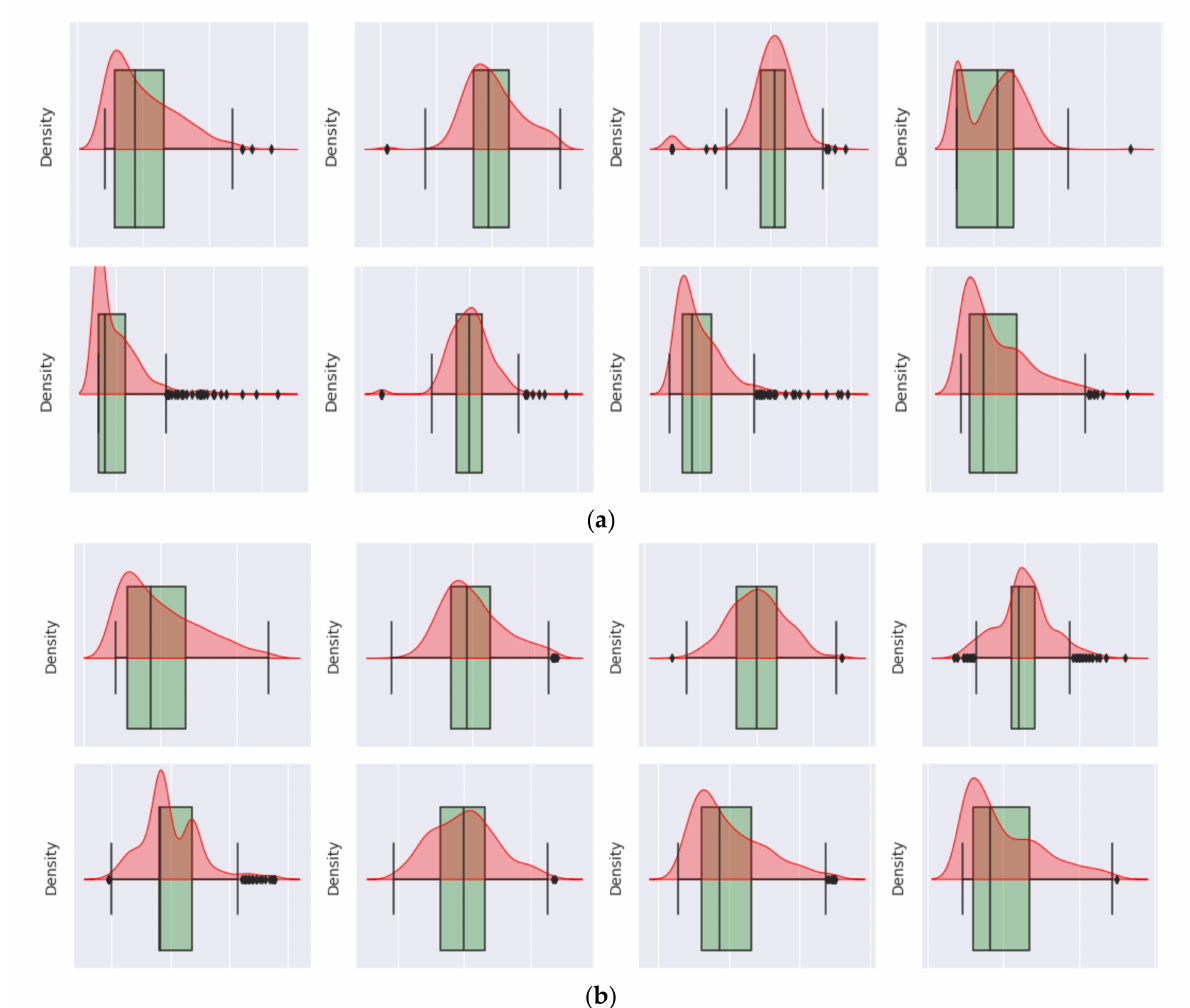
Figure 4. Boxplot of the feature distribution with ( a ) existing and ( b ) rejected outliers, so the first row is for features A1, A2, A3, and A4, and the second row is for features A5, A6, A7, and A8 (from left to right). ( a ) The appearance of a data outlier. ( b ) After outlier